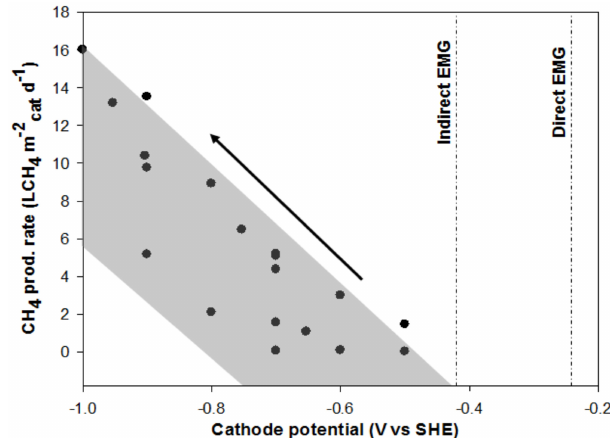
Figure 1. Summary (not exhaustive) of the existing EMG-BES literature [8,14–24]. Surface specific methane production rate values are reported versus applied cathode potential. Standard reduction potentials for direct and indirect EMG (at biologic relevant conditions) are reported for